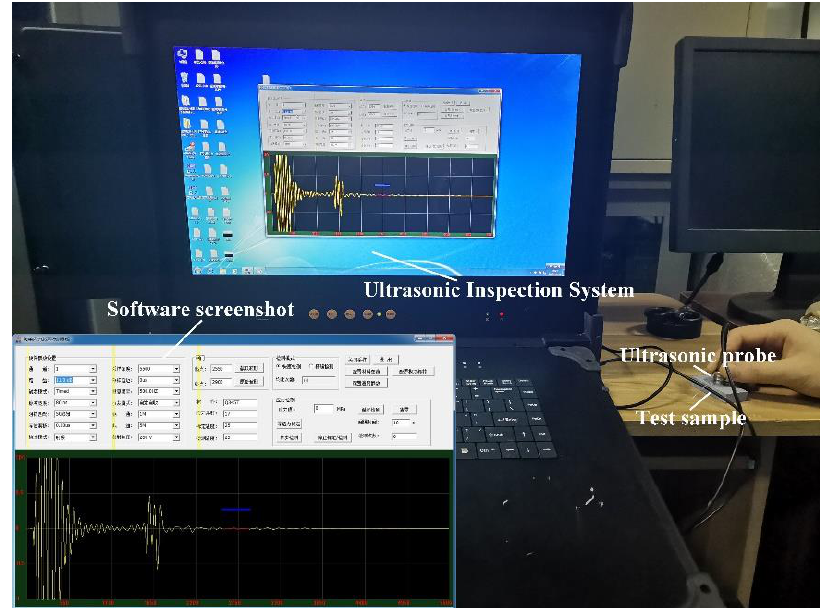
Figure 16. Ultrasonic attenuation coefficient measurement experiment.